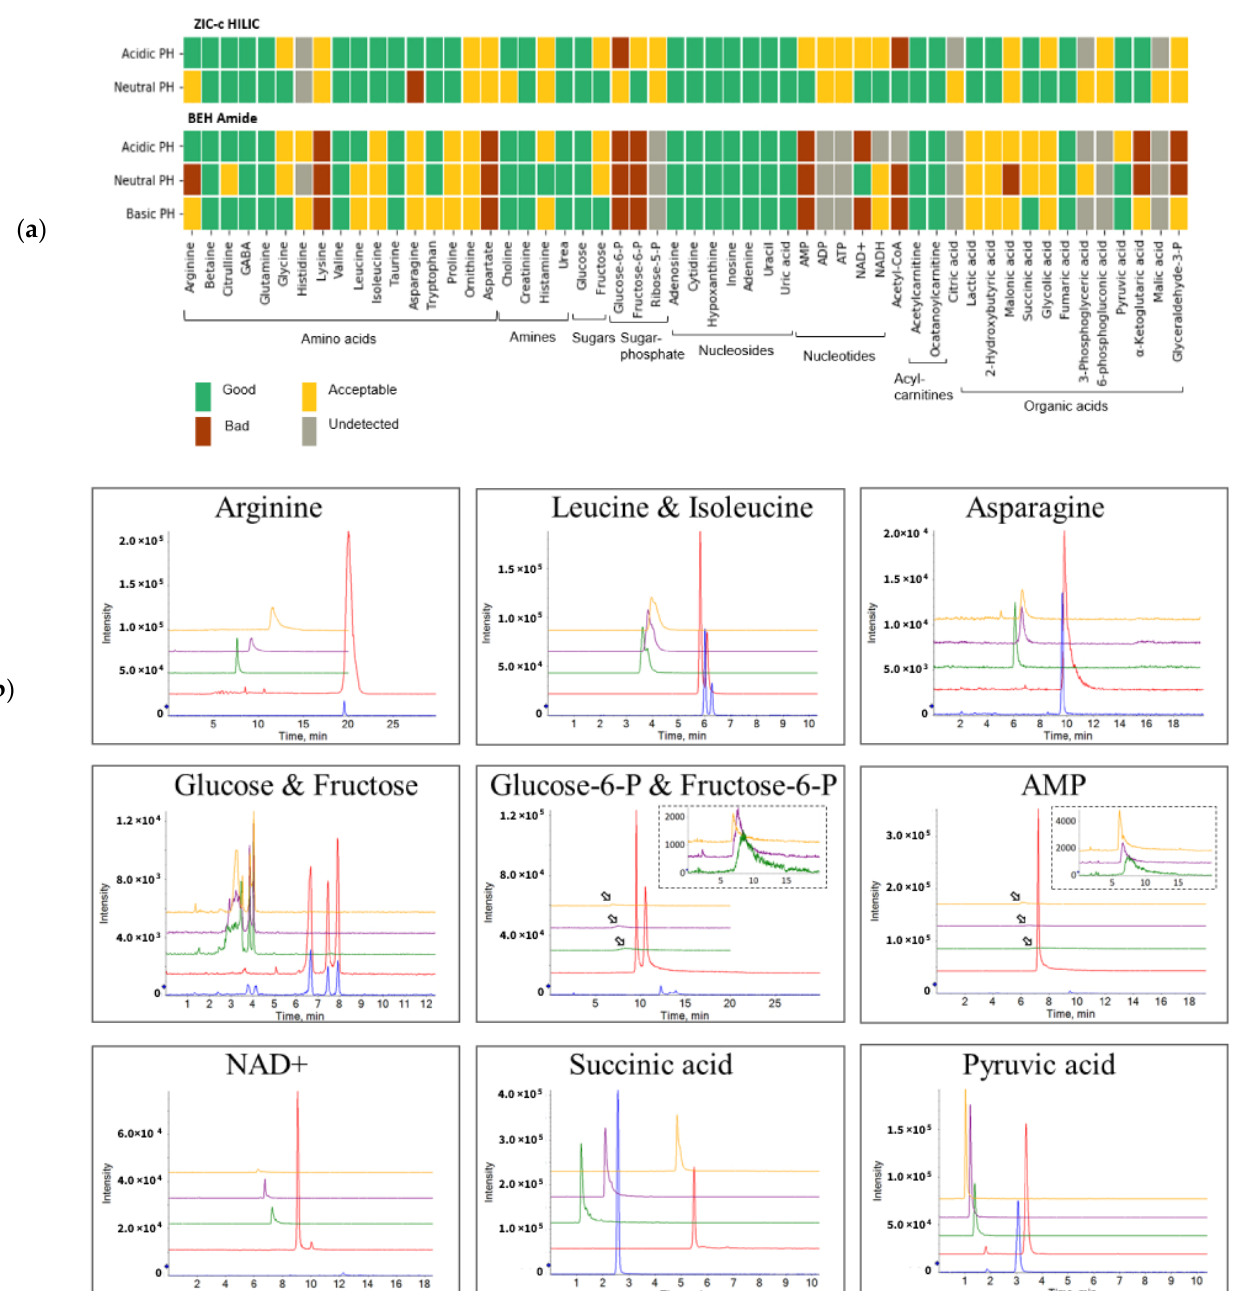
Figure 1. Overview of performance score and selectivity under chromatographic conditions. ( a ) In- dividual score of column performance for polar metabolites from different classes of compounds. ( b ) Column selectivity and chromatographic peak performance of representative metabolites from different classes under five different LC method conditions. Anomer mutarotation causes the glucose signal to split into two separate peaks as shown on both columns. The arrows represent the zoom figures. Blue: ZIC-c HILIC at pH 3; Red: ZIC-c HILIC at pH 7; Green: BEH Amide at pH 3; Purple: BEH Amide at pH 7; Yellow: BEH Amide at pH 10.